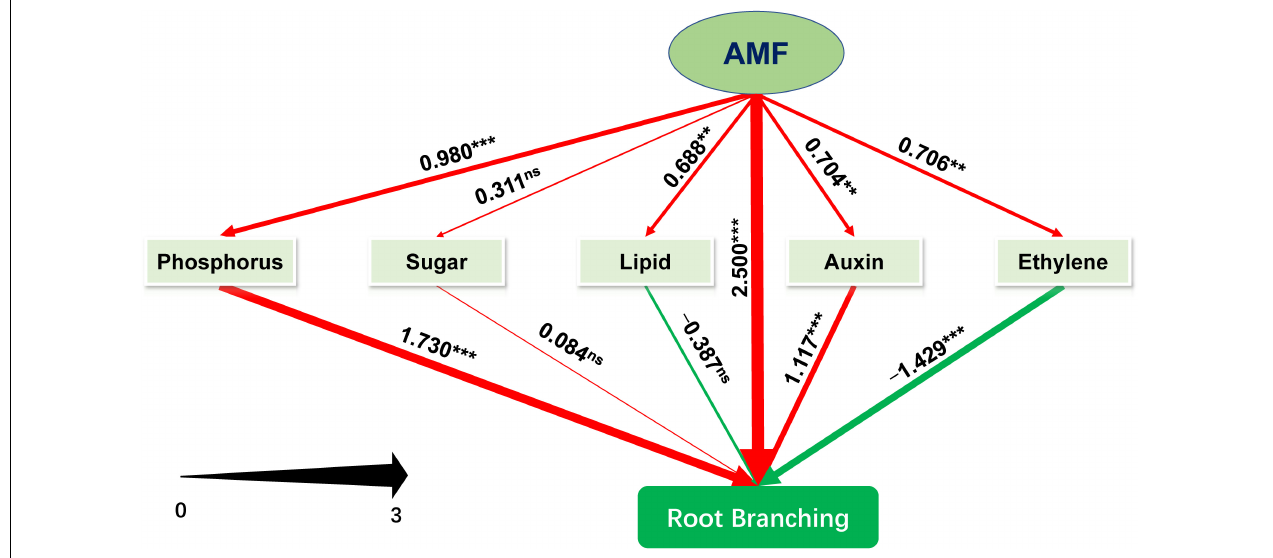
FIGURE 6 | Schematic diagram of the Partial Least Squares Structural Equation Modeling (PLS-SEM). Path coefficients were showed and reflected in the width of the arrows; positive effects are shown as red arrows, negative effects as green arrows. “‘***,” “**,” and “ns” means significance at p < 0.001, p < 0.01, and non-significance,